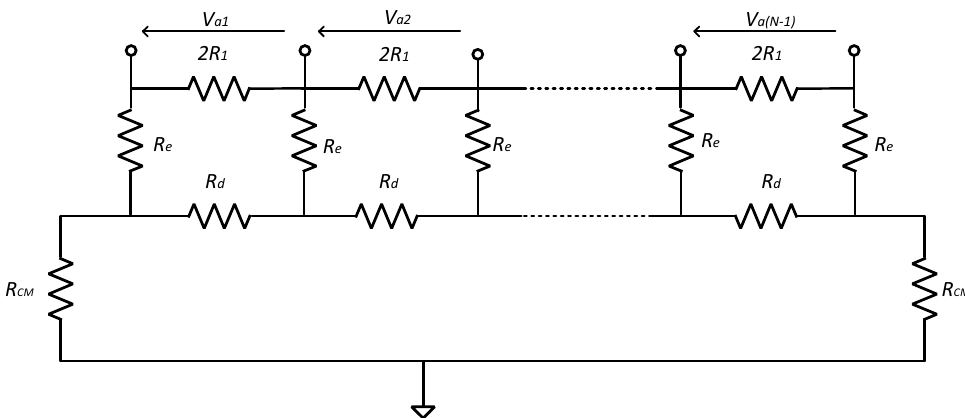
Figure 4. Simplified passband equivalent circuit for thermal noise analysis for a Type 2 circuit. This is a ladder expansion of Figure 2b, to which the same simplifying procedures have been applied as were used in Figure 3a. In addition, as already noted, for maximum signal gain we require that R 1 >> │ R e │ and so the circuit reduces to that of Figure 3b.